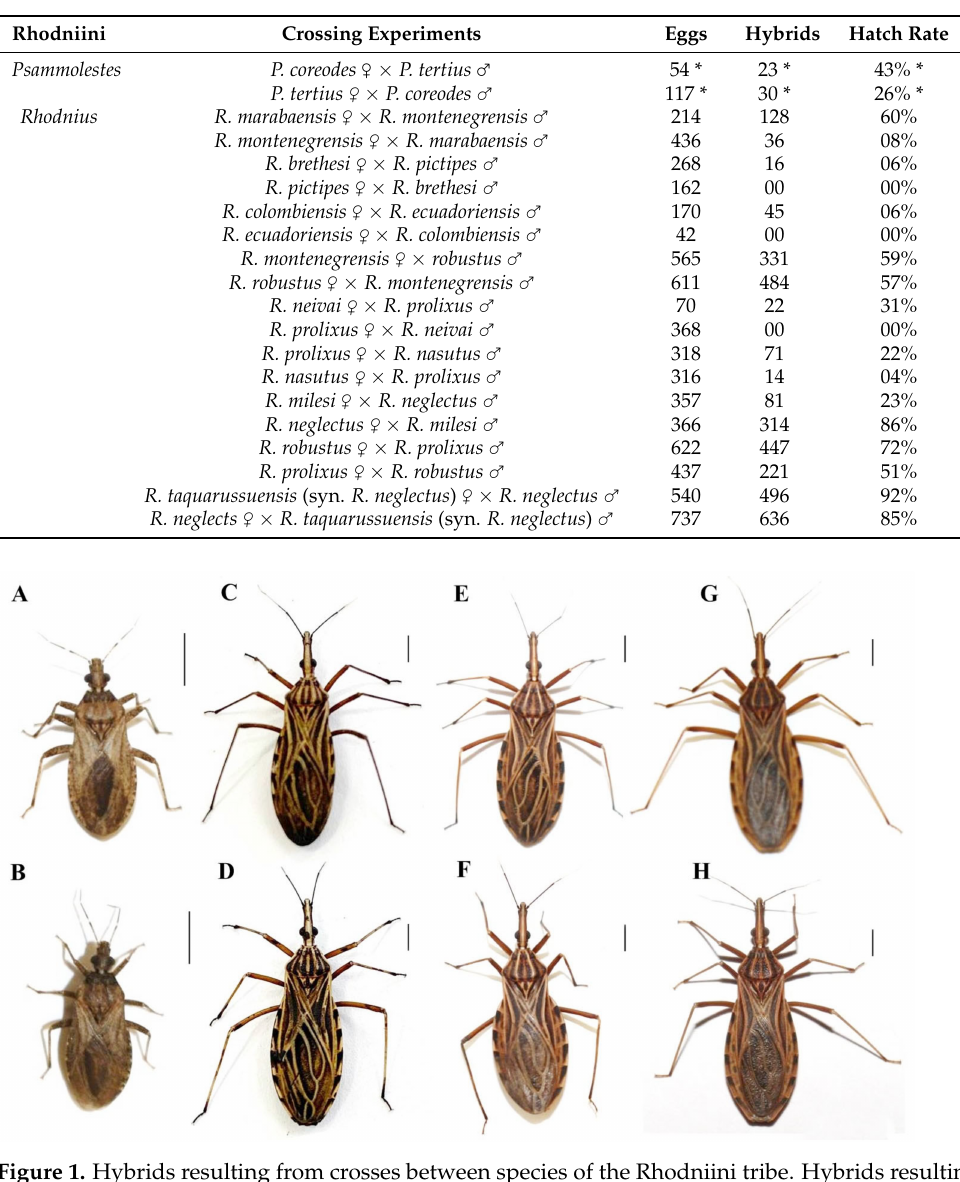
Table 3. Interspecific crosses performed in the Rhodniini tribe. * Data taken from Ravazi et al. [59].